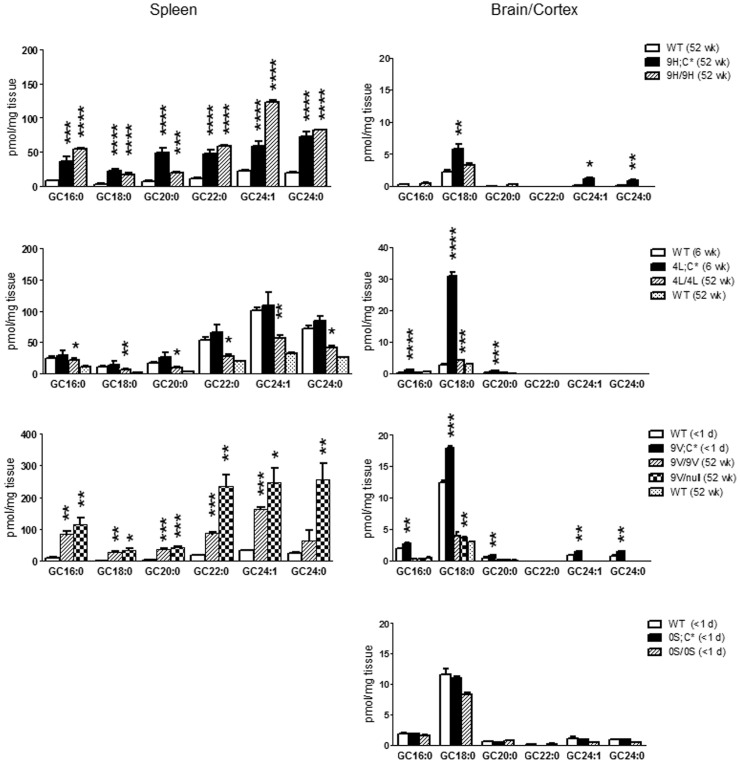
GC species in the spleen and brain.GC species in the spleen (9H/9H, 9H;C*, 4L/4L, 4L;C*, 9V/9V, and 9V/null), whole brain (9H;C*, 4L;C*, 9V;C*, 0S/0S, and 0S;C*) or cerebral cortex (9H/9H, 9V/9V, 4L/4L, and 9V/null) are presented. GCs in the brain extracts were resolved from galactosylceramide by hydrophobic interaction liquid chromatography and quantified by MS. The spleen of ∼1 day-old mice (0S/0S, 9V;C* and 0S;C*) were not determined. 4L;C* spleen at 6 wks was compared to WT at 9 wks. The data analyses were as in Figure 2.